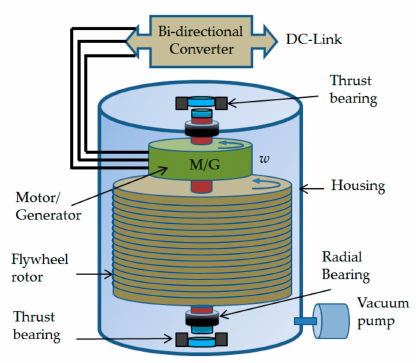
Figure 2. Structure and components of a flywheel